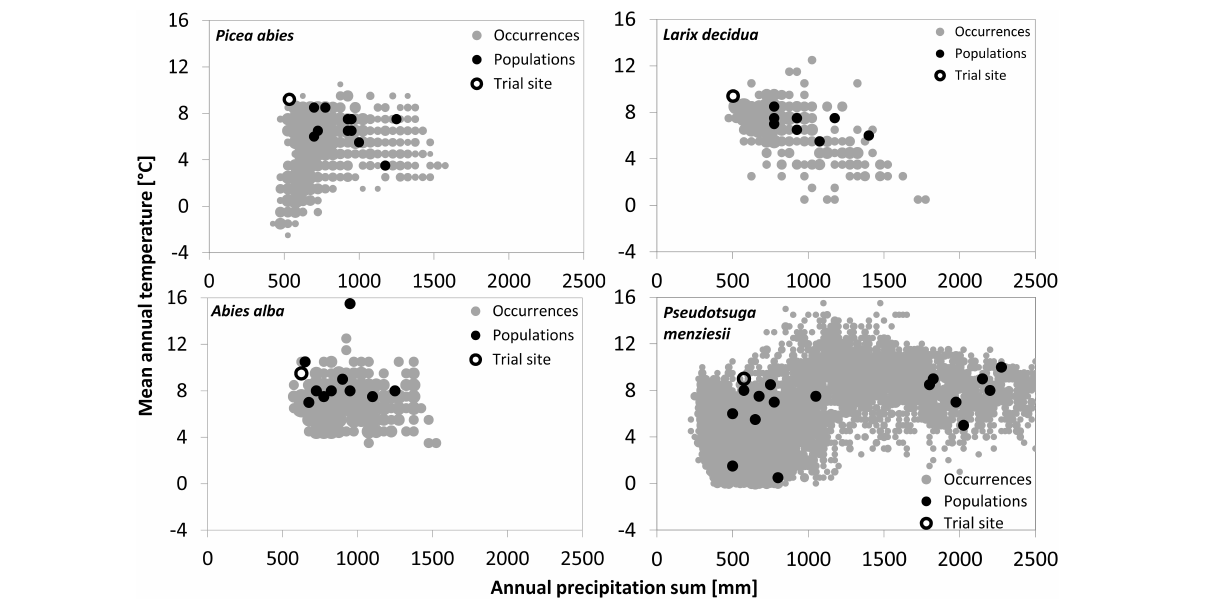
FIGURE 1 | Climatic origin of the tested provenances and the four trial sites in relation to the overall climate niche of the respective conifers. Species occurrences were obtained from the ICP Forest Program Level 1 for the three European species and from Schroeder et al. (2010) for Douglas-fir. Climate data of species occurrences and provenance origin are based upon WorldClim climate data ( Hijmans et al., 2005), whereas the trial site climate represents the mean climate from 1961 to